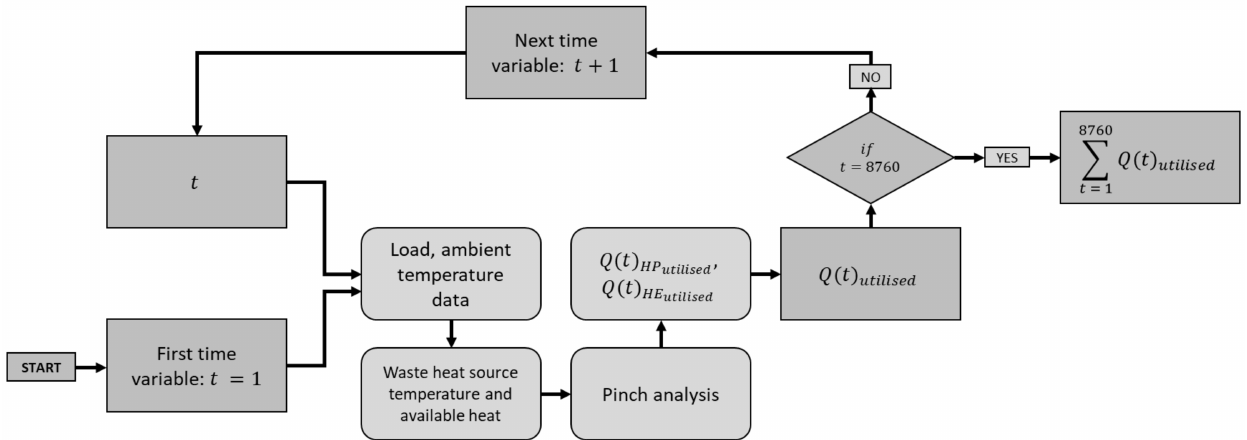
Figure 2. Time variable method